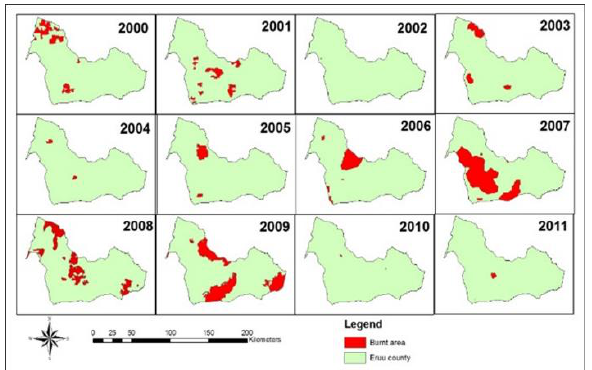
Figure 4. Burnt area distribution image by MODIS image of study area (2000 to 2011)